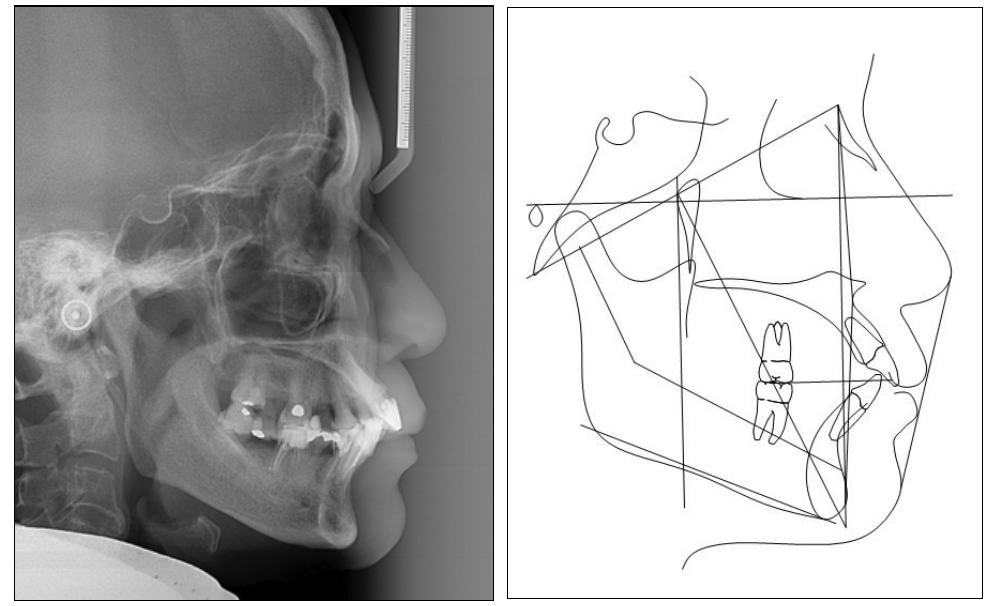
Figure 4. Pretreatment orthodontic diagnostic photographic records.